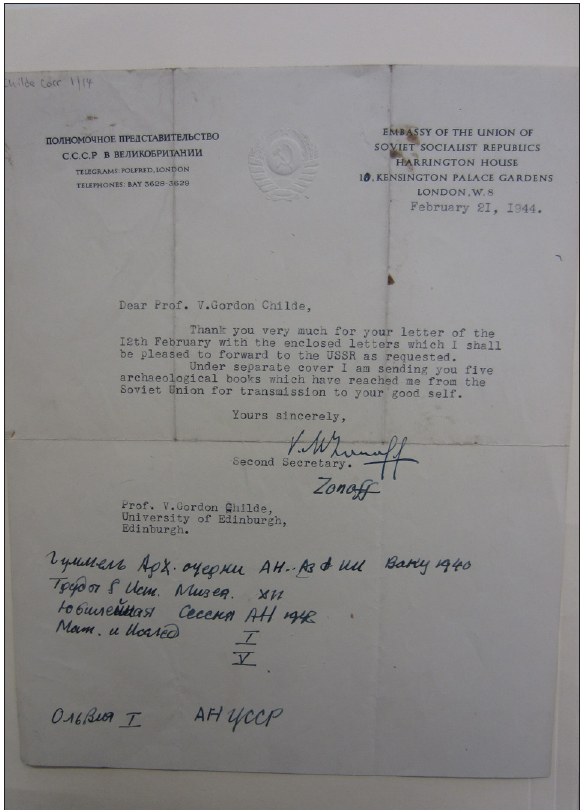
Figure 3: Letter from Zonoff, Second Secretary of the Soviet Embassy, to Childe with a listing in Russian of the books delivered to him. 1944. (Photo UCL Institute of